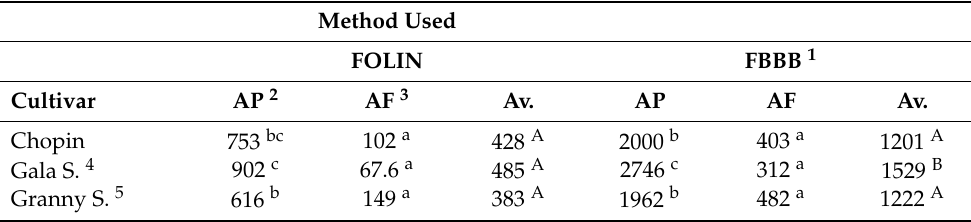
Table 2. Effect of the cultivar and tissue type on the total phenolic concentrations (mg GA kg − 1 FW). Results according to FBBB and Folin-Ciocalteu